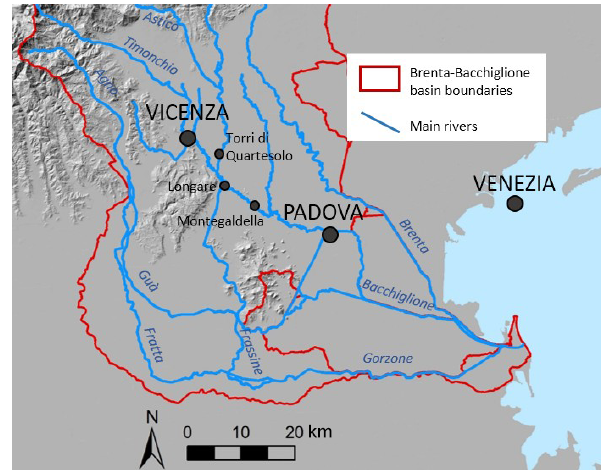
Figure 2. Location of the Brenta-Bacchiglione catchment and its urban